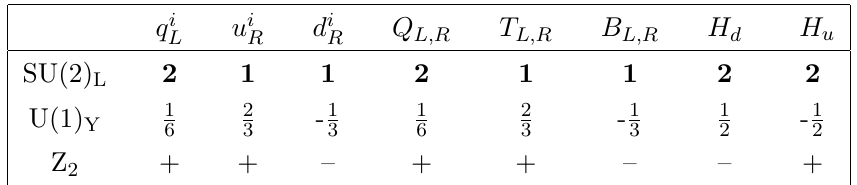
; u i ; d i for i = 1 ; 2 ; 3), extra vectorlike L R R